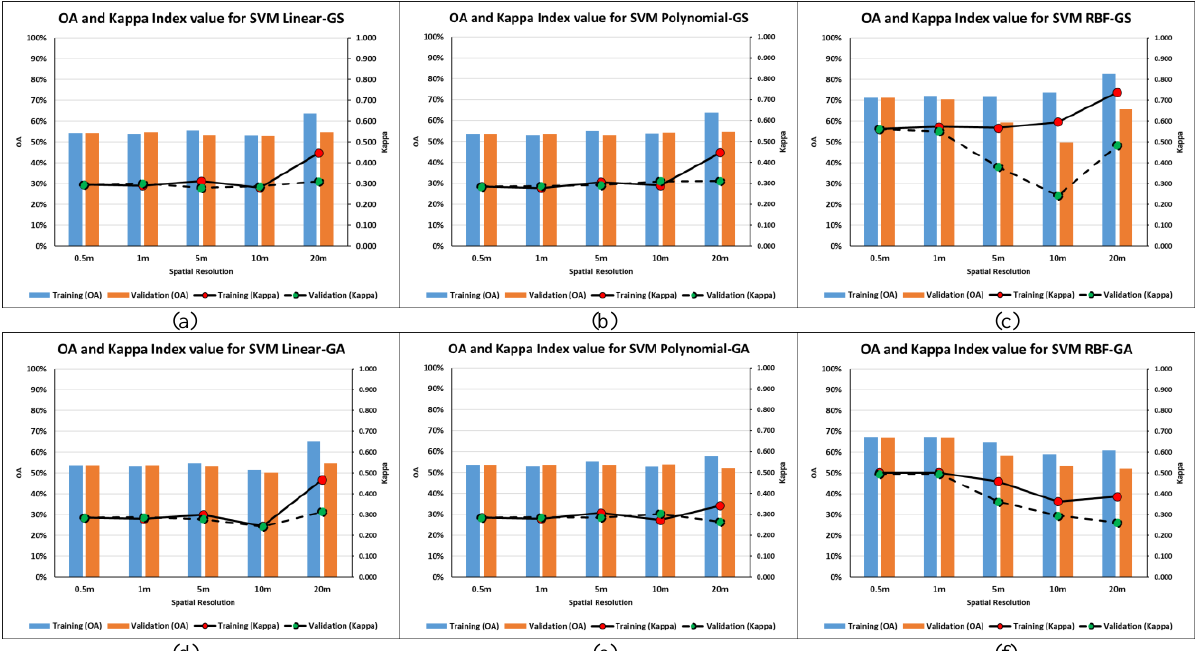
Figure 5 . Overall accuracy and kappa coefficient of classified landslide activity for shallow, translational landslide with different spatial resolution using (a) SVM Linear-GS, (b) SVM Polynomial-GS, (c) SVM RBF-GS, (d) SVM Linear-GA, (e) SVM Polynomial-GA, and (f) SVM